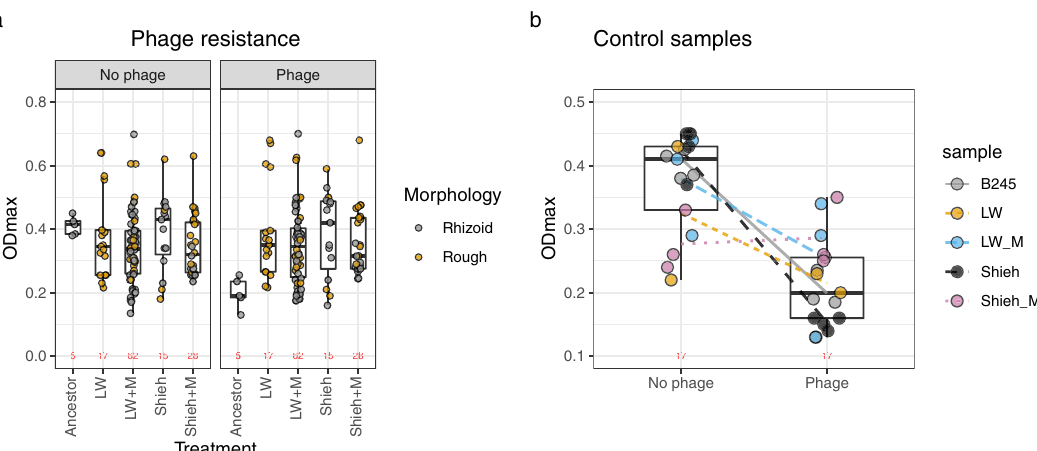
Fig. 4 Effect of environment and colony morphology on bacterial growth. Each dot represents the mean of three replicate OD measurements of an isolate. The box plots capture the minimum and maximum values, 25th and 75th percentile (box) and the median (black horizontal line) of these dots. The number of observations is shown in red for each dataset. a Ancestral B245 and isolates originating from the four treatments in the presence or absence of phage. b Control samples (grown without phage) from the same four treatments plus the ancestor in the presence or absence of phage. The box plots represent all treatments, including ancestor bacteria. Lines visualize the change in mean ODmax per sample. Source data are provided as a Source Data fi le.